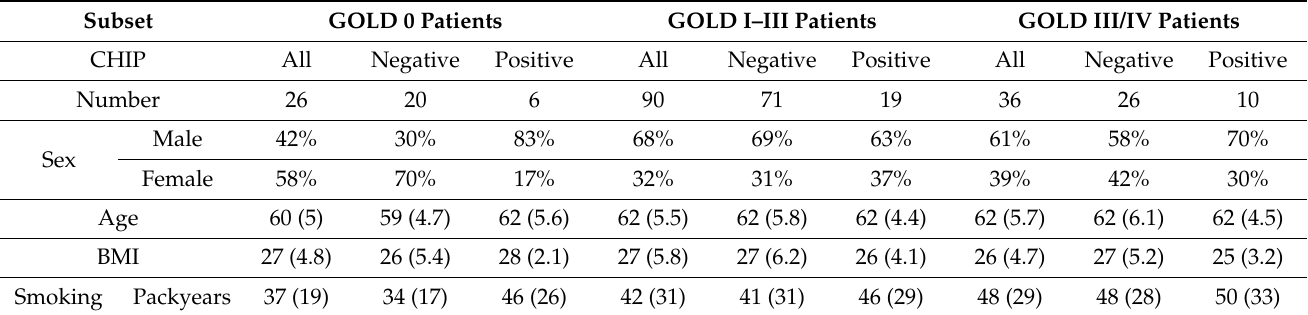
Table 1. Detailed characteristics of CHIP in COPD patient cohort (COSYCONET). Subset GOLD 0 Patients GOLD I–III Patients GOLD III/IV